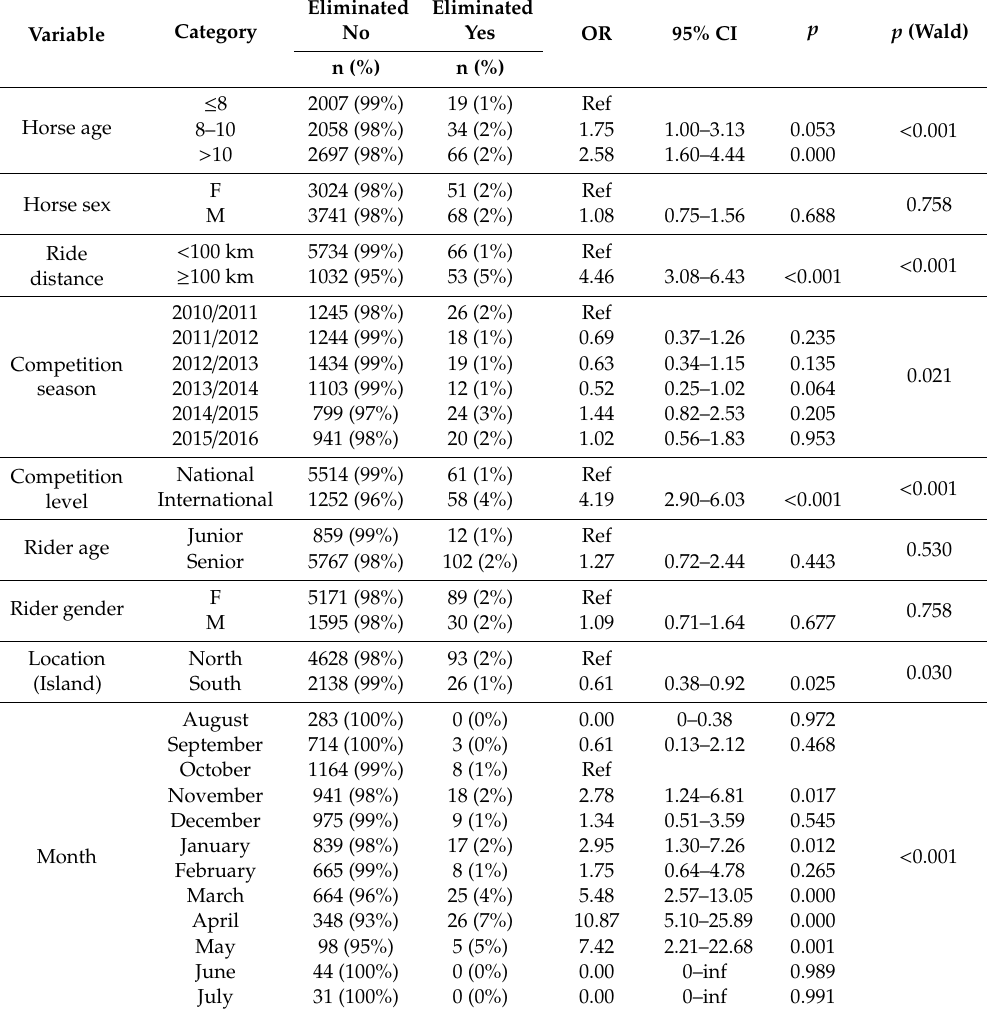
Table 4. Univariate logistic regression of associations between ride elimination (No / Yes) due to metabolic reasons only and the predictor variables; horse age and sex, ride distance ( < 100 km or ≥ 100 km), competition season, competition level (national or international), rider age (junior or senior), rider gender, location (North or South island of New Zealand) and month of